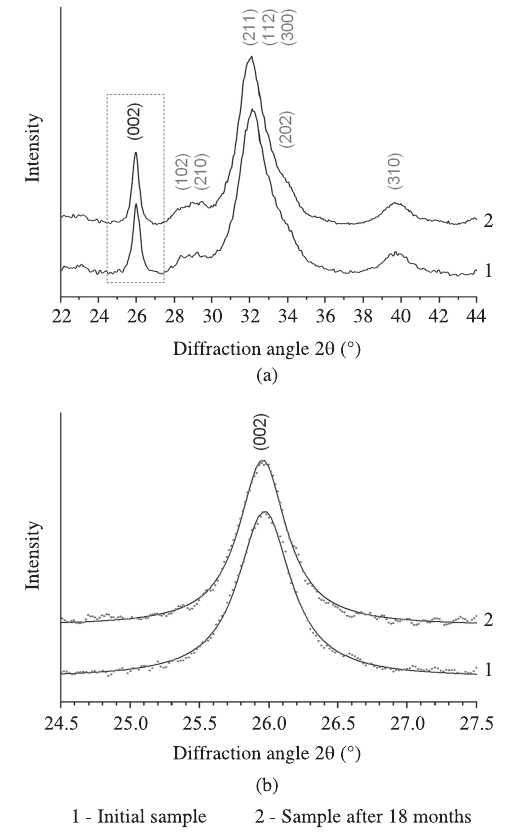
Figure 2. XRD analyses of the mineral sample over storage time. (a) XRD patterns of the initial sample (1) and of the same sample after 18 months of storage (2). Both patterns showed similar features, comprising broad, overlapping peaks indexed as reflections of hydroxyapatite planes (ICDD PDF 9-432). The (002) reflection was the only isolated, well-defined peak, being used to further analysis. (b) Curve-fitting analysis of the (002) reflection of the initial sample (1) and the same sample after 18 months of storage (2). Dotted line: experimental peak; Full line: fitted peak. The FWMH values obtained by this analysis were used to estimate the degree of crystallinity of the samples, as presented in Table